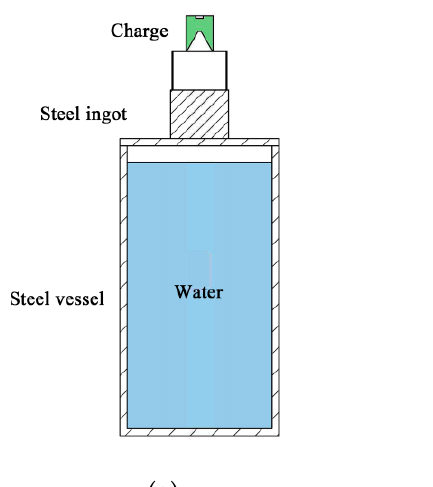
Figure 4. Layout of the site of the SCJ recovery experiment. ( a ) Schematic of the experimental setup; ( b ) Experimental site.